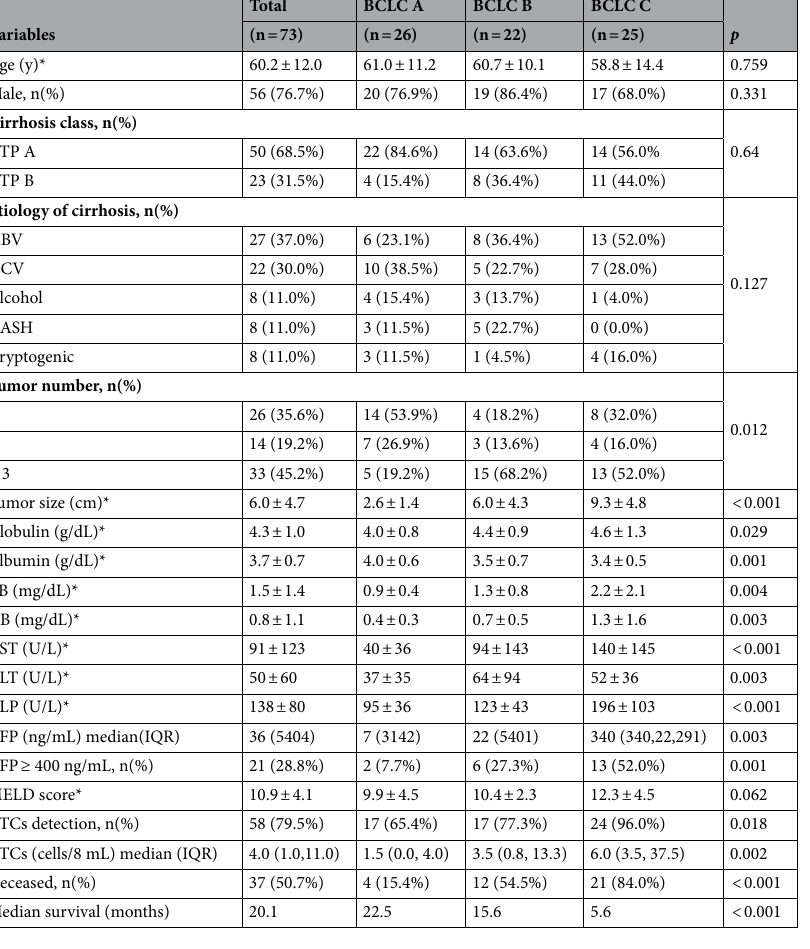
Table 1. Baseline characteristics of HCC patients in the study cohort. Data with * are presented as mean ± standard deviation. AFP Alpha fetoprotein, ALBI Albumin-bilirubin score, ALP Alkaline phosphatase, ALT Alanine aminotransferase, AST Aspartate transaminase, BCLC Barcelona clinic liver cancer, cm Centimeter, CTCs Circulating tumor cells, CTP Child-Turcotte-Pugh score, DB Direct bilirubin, g/dL Gram per deciliter, HBV Hepatitis B virus, HCV Hepatitis C virus, IQR Interquartile range, MELD Model for end- stage liver disease. NA Not applicable, ng/mL Nanogram per milliliter, NASH Nonalcoholic steatohepatitis, SD Standard deviation, TB Total bilirubin, U/L Units per